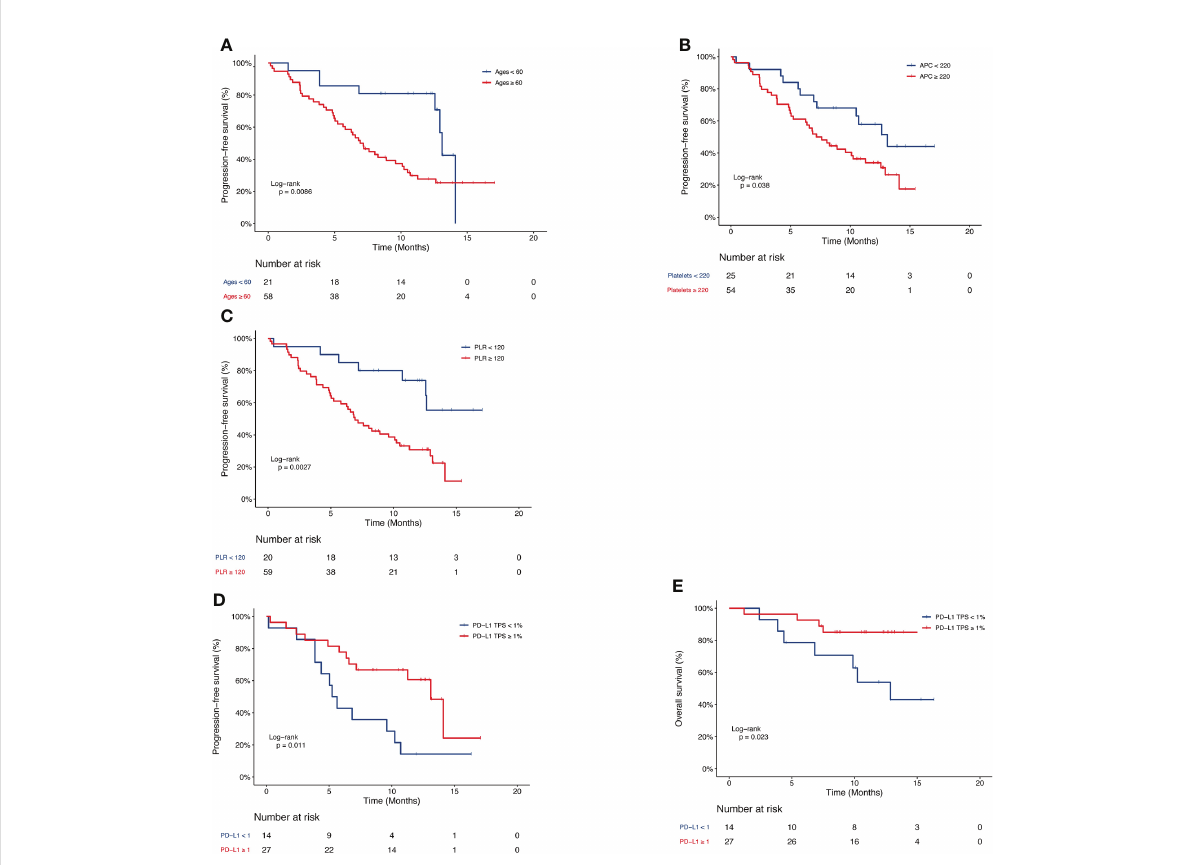
FIGURE 2 Kaplan-Meier curve of PFS or OS of patients in the pembrolizumab group. PFS of patients strati fi ed by (A) age, (B) APC, (C) PLR and (D) PD-L1 TPS. (E) OS of patients strati fi ed by PD-L1 TPS. PFS, progression-free survival; OS, overall survival; APC, absolute platelet count; PLR, platelet-to- lymphocyte ratio; PD-L1 TPS, programmed death-1 tumor proportion score.